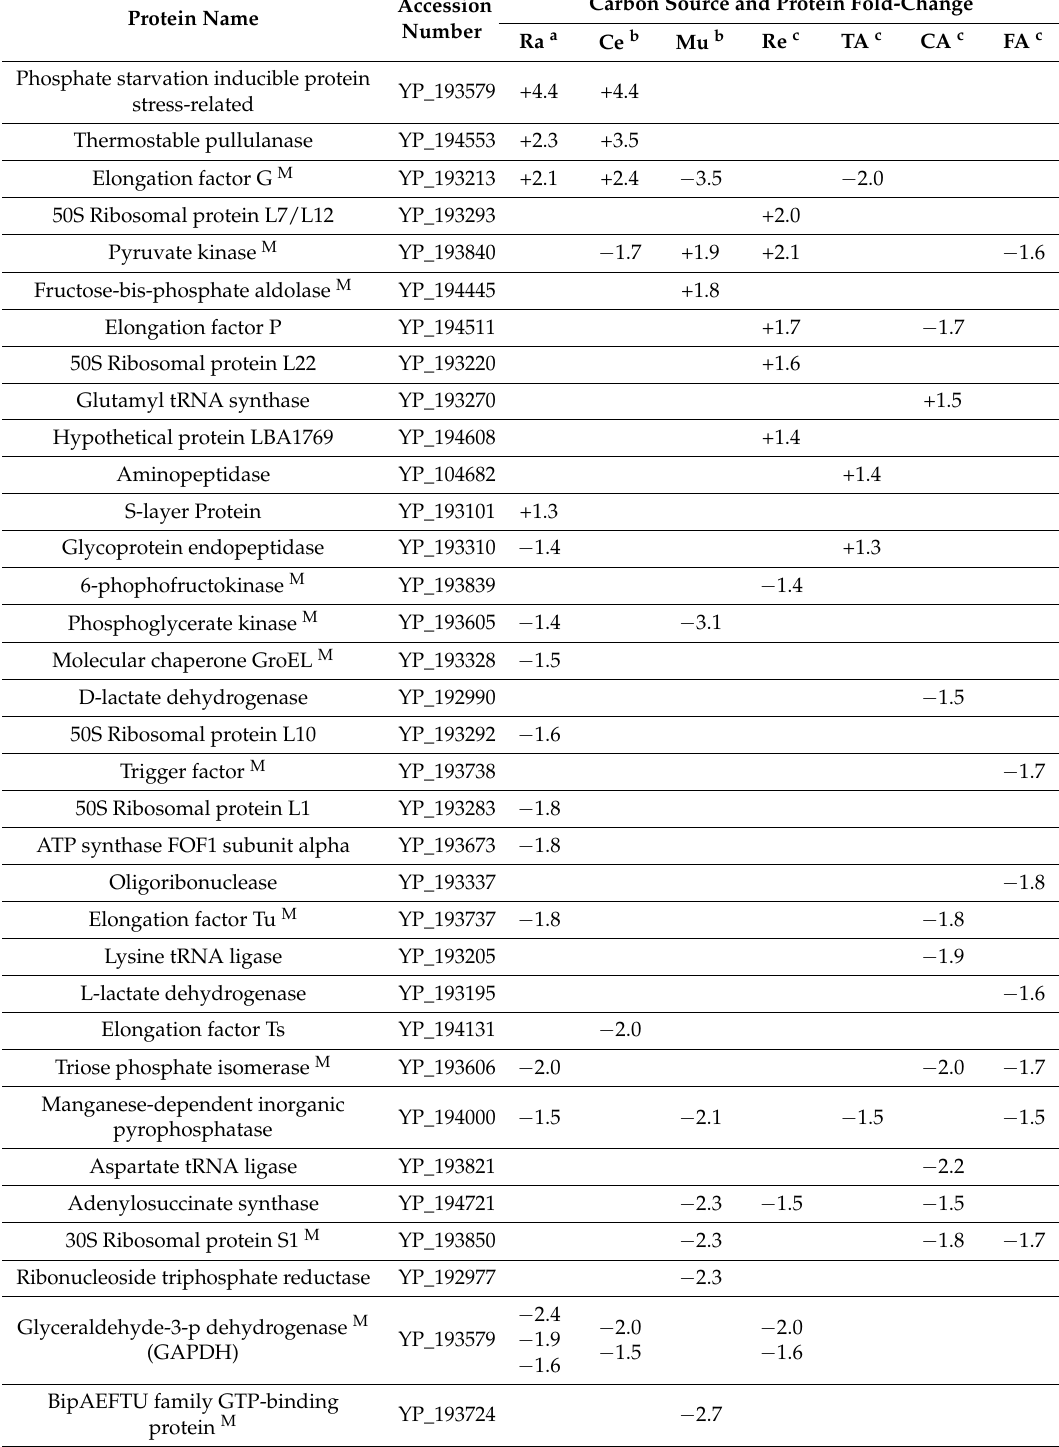
Table 2. Surface proteins showing relative abundancy changes in Lactobacillus acidophilus NCFM with increased adhesive